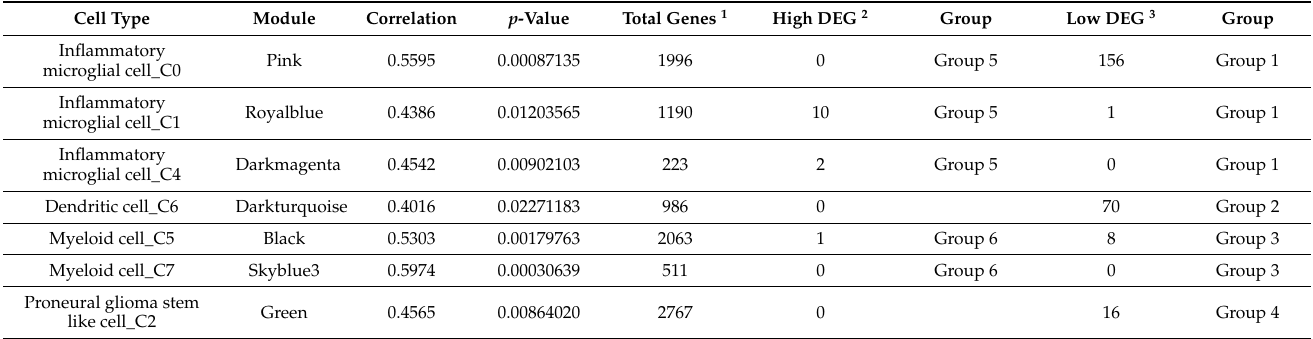
Table 1. WGCNA and DEG results on top seven highly expressed cells.